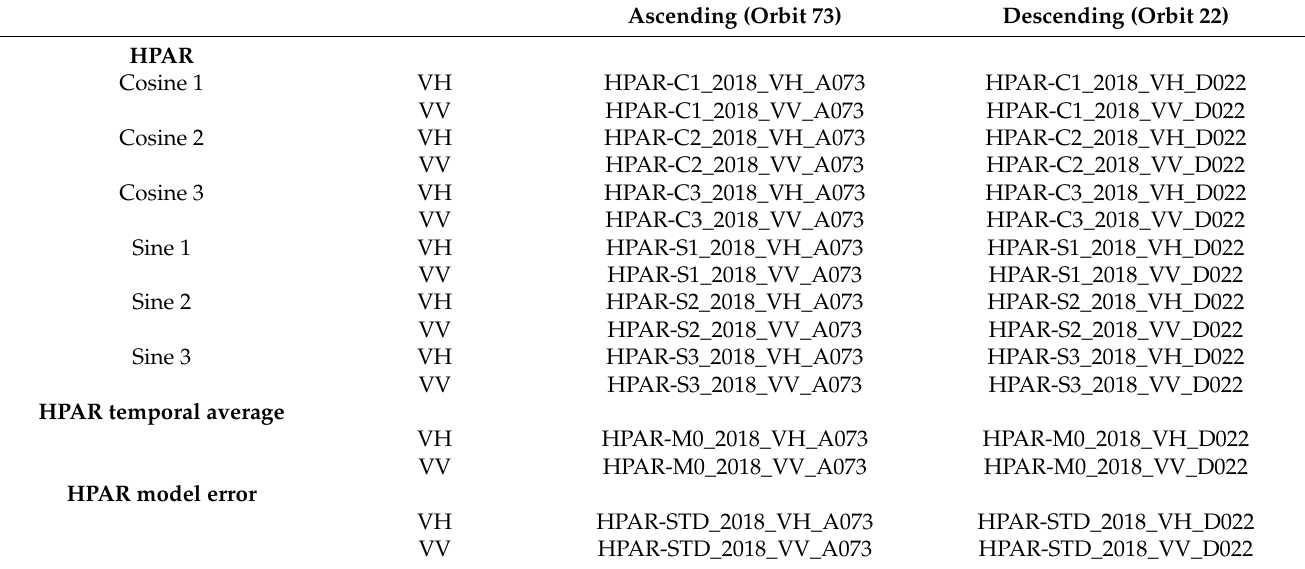
Table 4. Summary of the Sentinel-1 harmonic parameters of the 2018 vegetation period used for